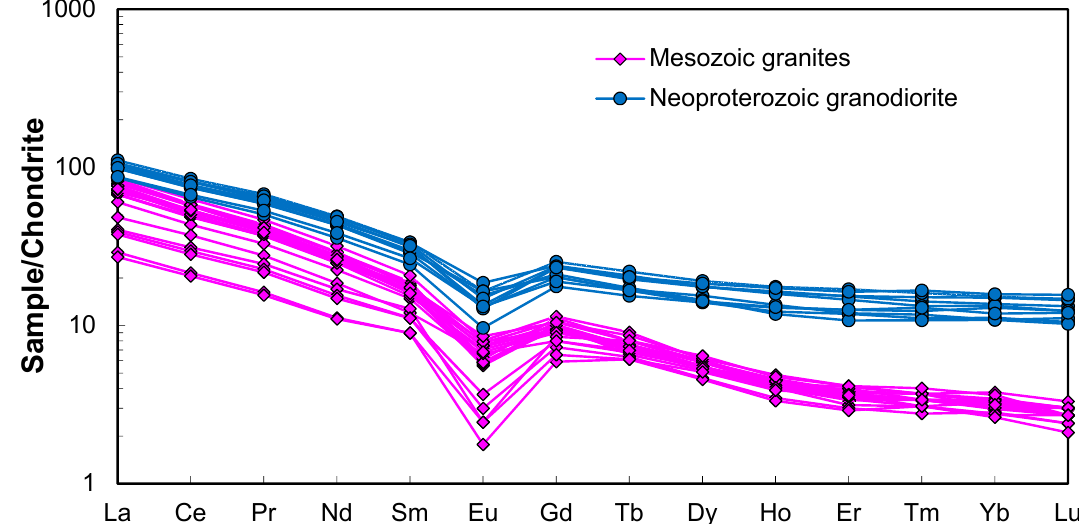
Figure 5. Chondrite-normalized REE patterns of the Shimensi granodiorite. Normalization values are from Sun and McDonough [41]. Data of the ore-related Mesozoic Shimensi granites are from Wei et al. [6].